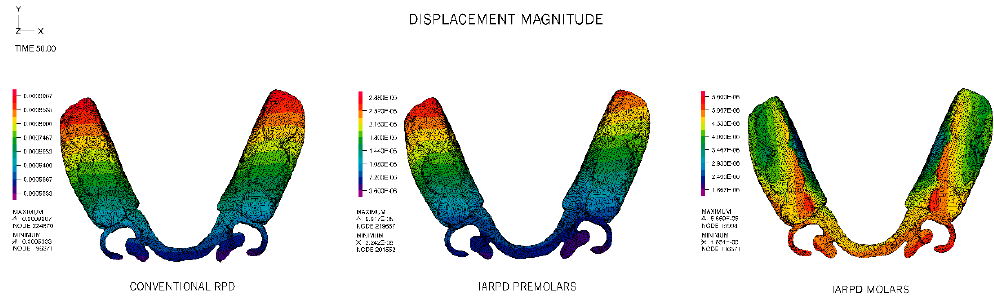
Figure 4. Distribution of the global displacements of the elements in each of the three models: CONVENTIONAL RPD ( left ), IARPD PREMOLARS ( center ), IARPD MOLARS ( right ). Non-matching colour scales. Homologous bands of the CONVENTIONAL RPD and IARPD PM models have 100 times discrepancy in values.